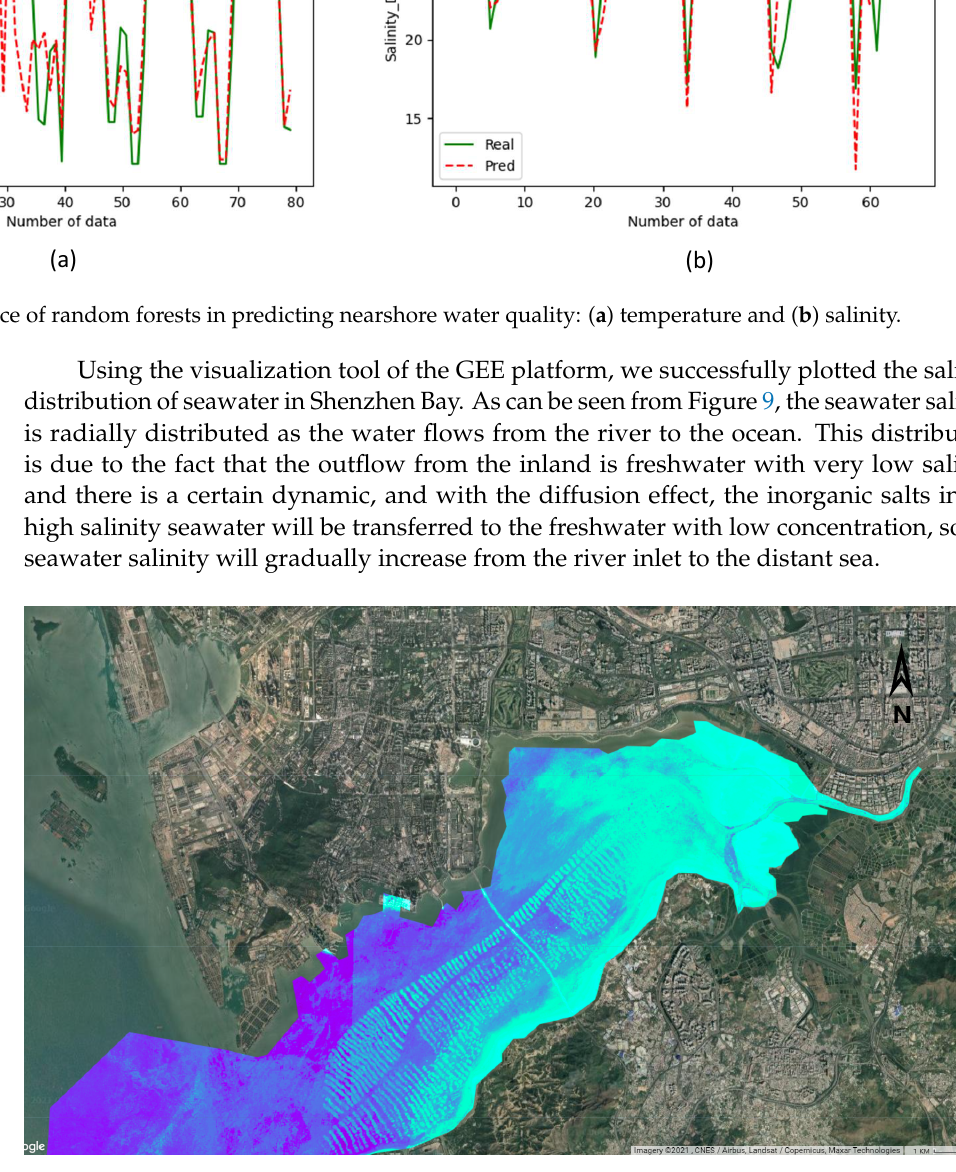
Figure 9. Salinity distribution of seawater in Shenzhen Bay predicted by random